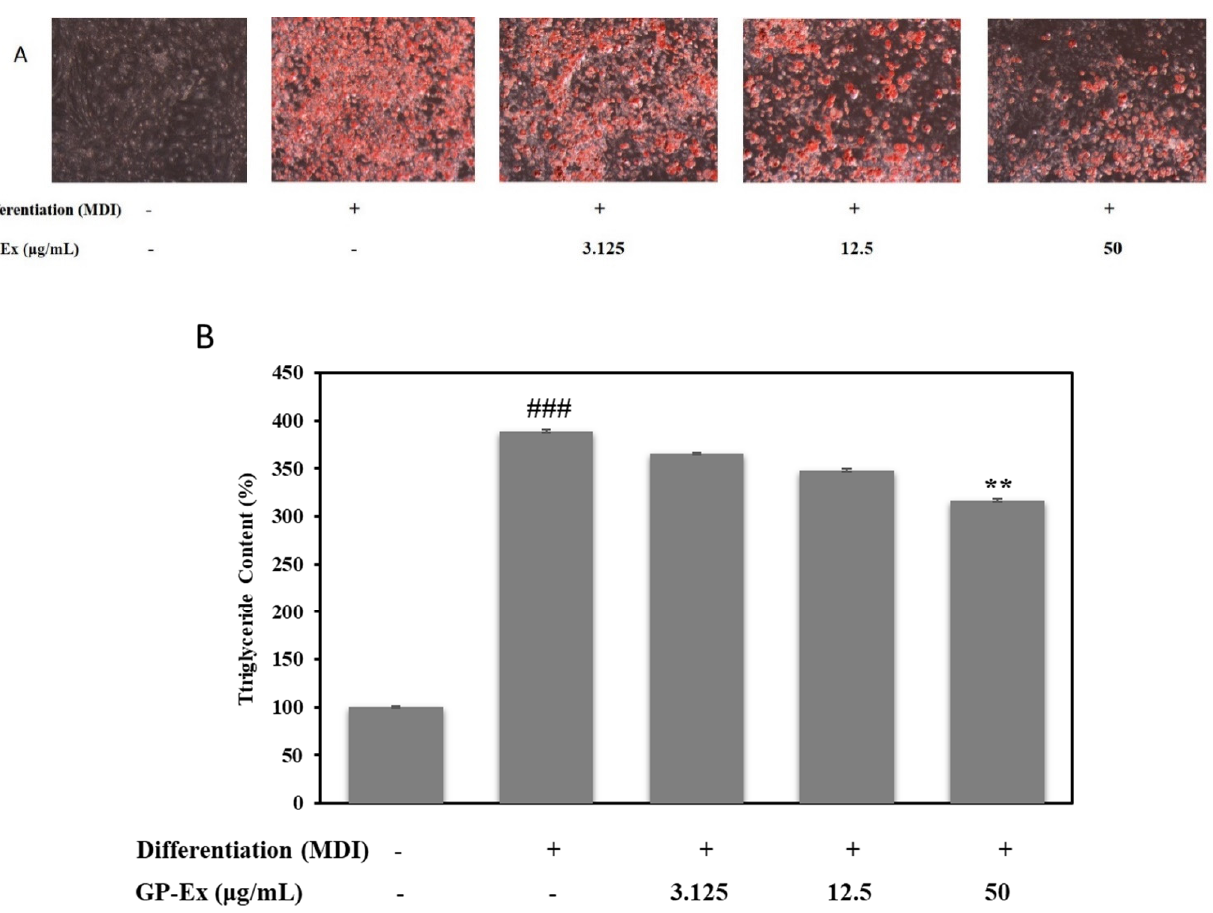
Figure 8. Inhibitory Effect of the lipid accumulation for GP extract on MDI-induced 3T3-L1 adipocytes. ( A ) Fat droplets were measured by oil red O staining and observed using a microscope (at × 40). ( B ) The absorbance of lipid accumulation, which was oil red O dye, was dissolved in isopropyl alcohol (520 nm). The data are mean values of three experiments ± SEM; ### <0.01 compared with control, ** p < 0.01 compared with the MDI.